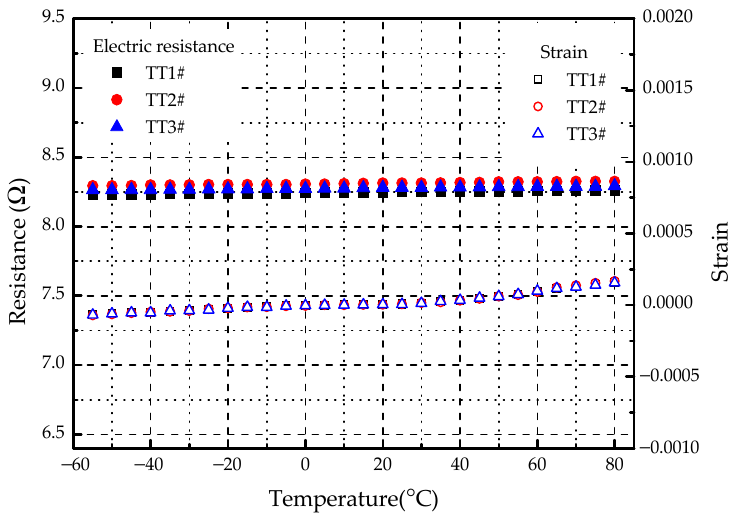
Figure 7. Variation of electric resistance and strain along with temperature.